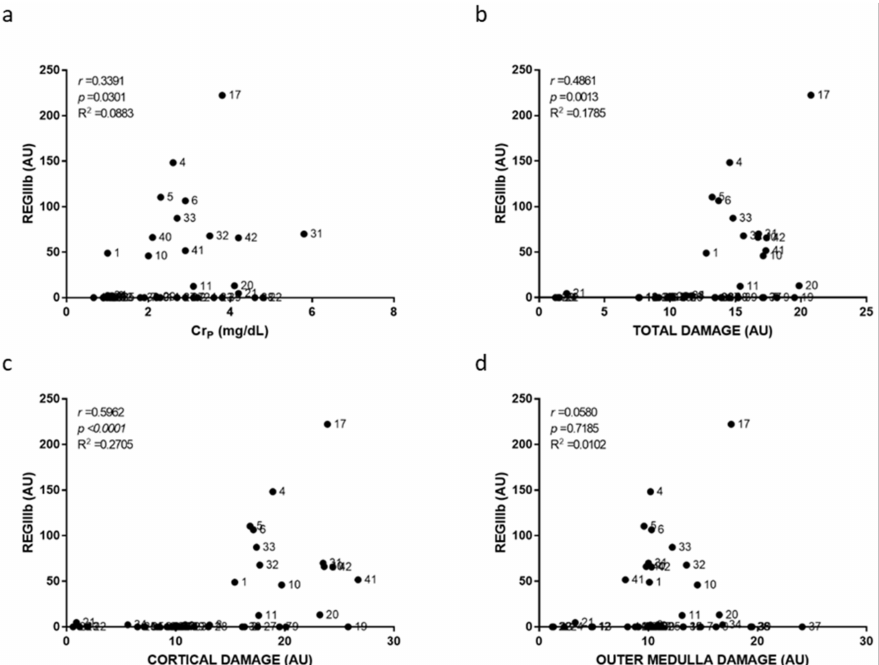
Figure 7. Urinary REGIIIb to plasma creatinine and to renal damage relationships. Scatter plots showing the relationship between urinary REGIIIb levels and plasma creatinine concentration (Cr p ) ( a ), with the overall renal tissue damage ( b ), renal cortical damage ( c ), and outer medullary damage ( d ) of individual rats. AU: arbitrary units. p : Spearman’s correlation p -value. r : Spearman’s correlation coefficient. R 2 : linear regression coefficient of